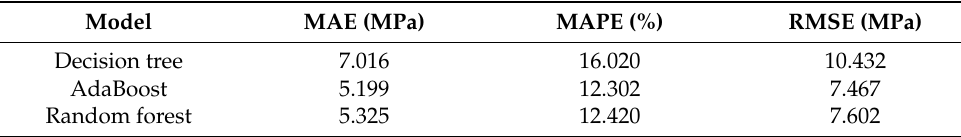
Table 2. Statistical assessments of the models employed in this study.